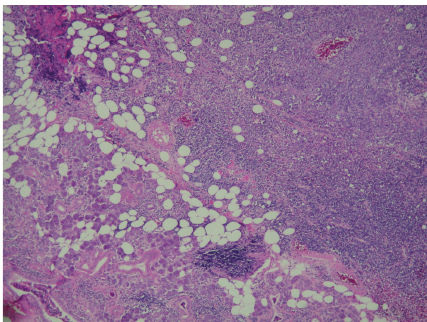
Figure 3: Ki-67 immunostain showing high proliferation